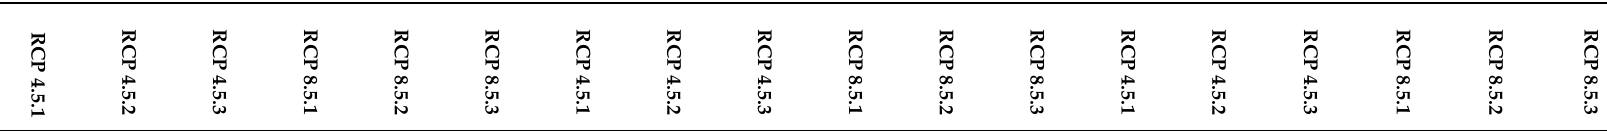
Table 8. Comparison of the average monthly sum of actual evapotranspiration for the SWAT simulation period 2010–2017 with individual projections for the